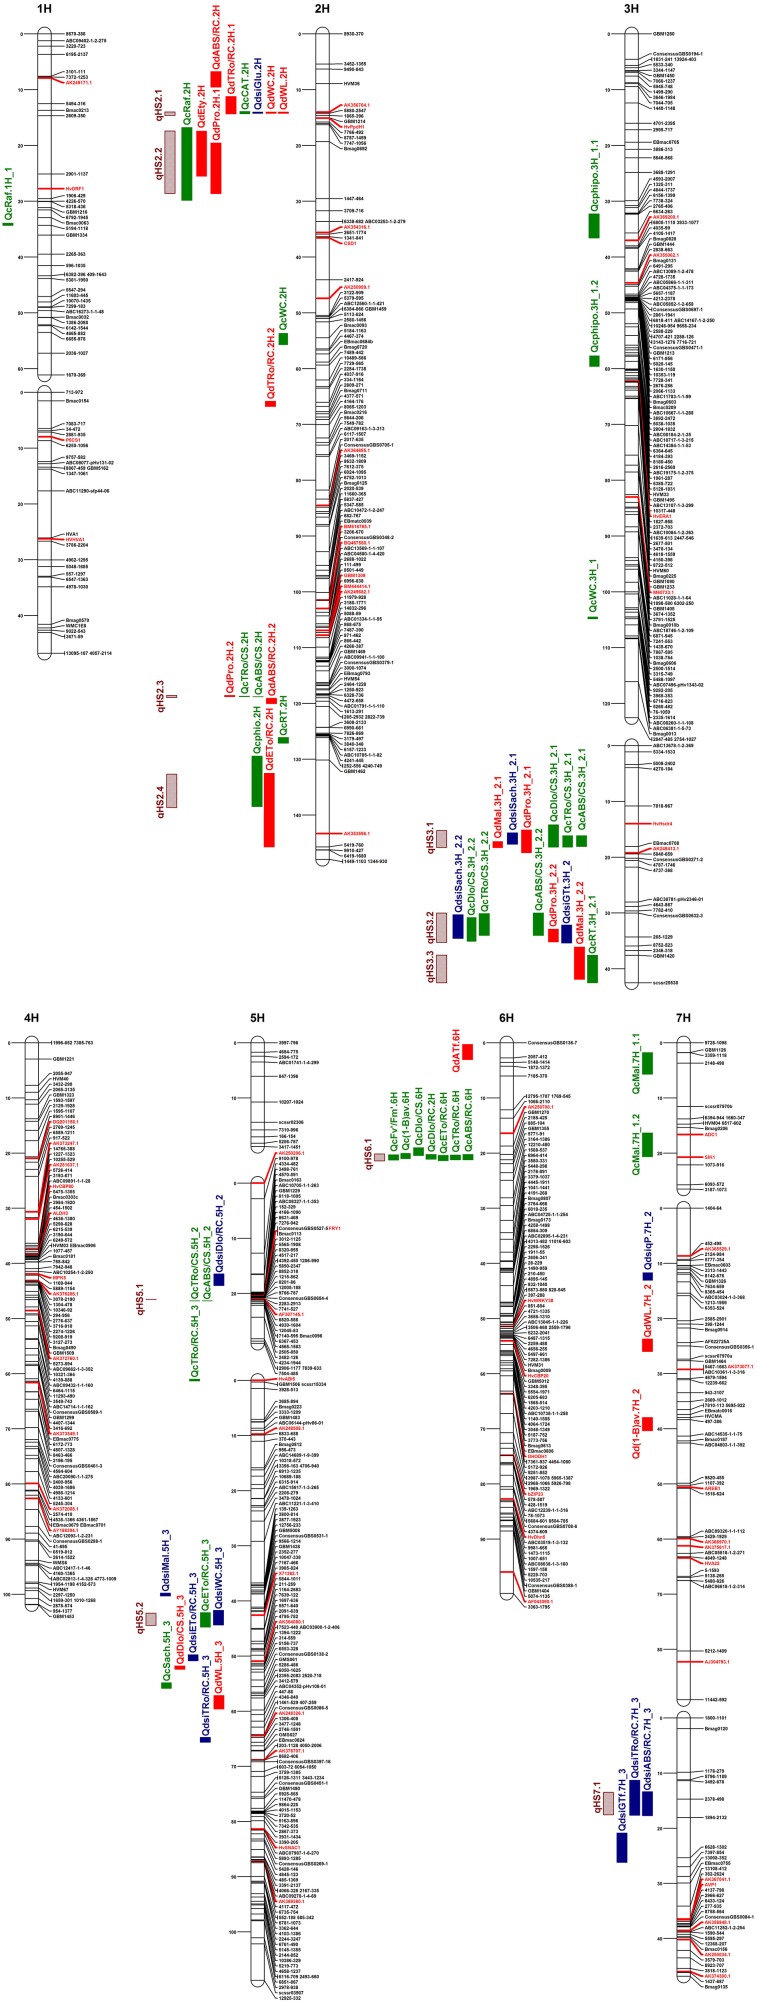
High-density consensus function map of barley with the positions of QTLs for physiological and biochemical traits related to the drought stress response. Markers are given on the right side of the linkage groups. Functional candidate genes are given in red. Bars represent intervals associated with QTLs for: drought stress (red), control conditions (green), stress indices (blue), and QTL hotspots (patterned).